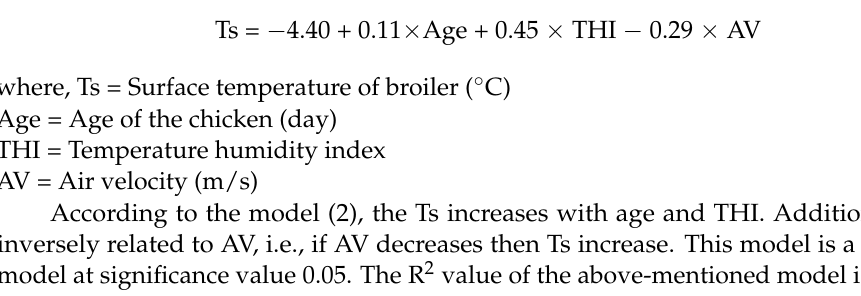
Figure 6. Correlation matrix for the dependent and independent factors. The asterisks (“***”, “**”, “*”, “.”, " “) indicate the significance levels of the correlations at different significance level (0, 0.001, 0.01, 0.05, 0.1, 1).